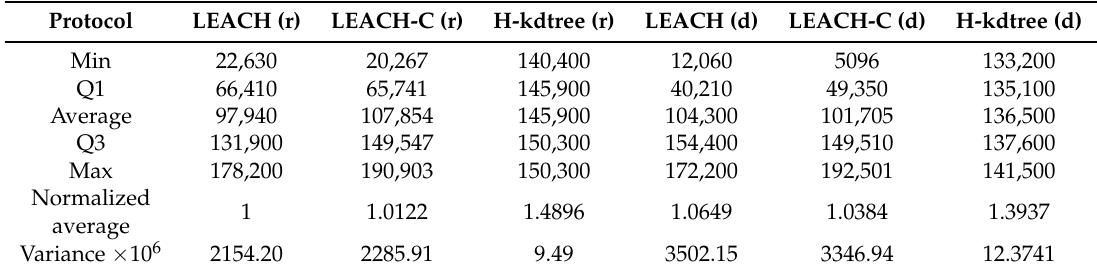
Table 8. Throughput with 200 nodes. (r) random—(d) deterministic.